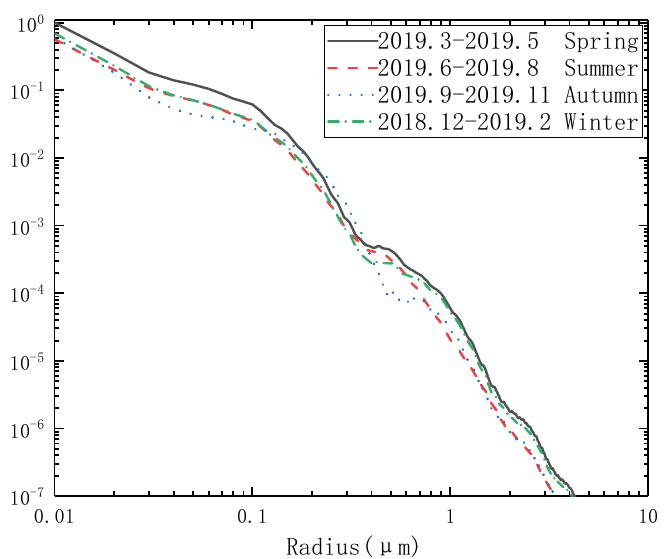
Figure 5. The aerosol PSDs of all seasons in the Yinchuan area from the AODS shown in Figure 3 inverted by the TSVD regularization